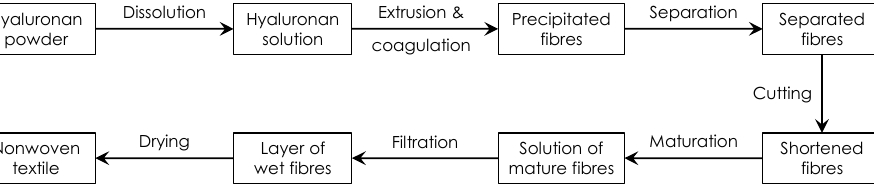
Figure 1. Scheme depicting the sequence of main production steps during the preparation of a nonwoven textile from HA.